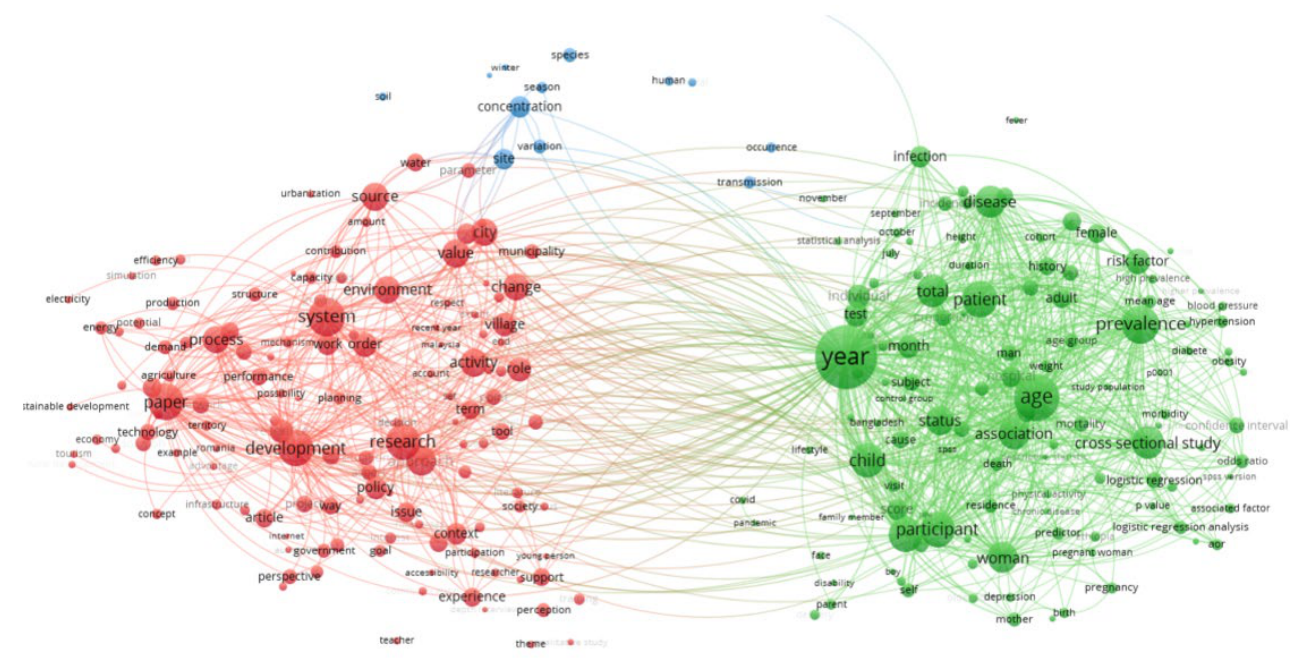
Figure 1. Visualization of the co-occurrence networks of the keywords in scientific publications containing the term “rural area”.